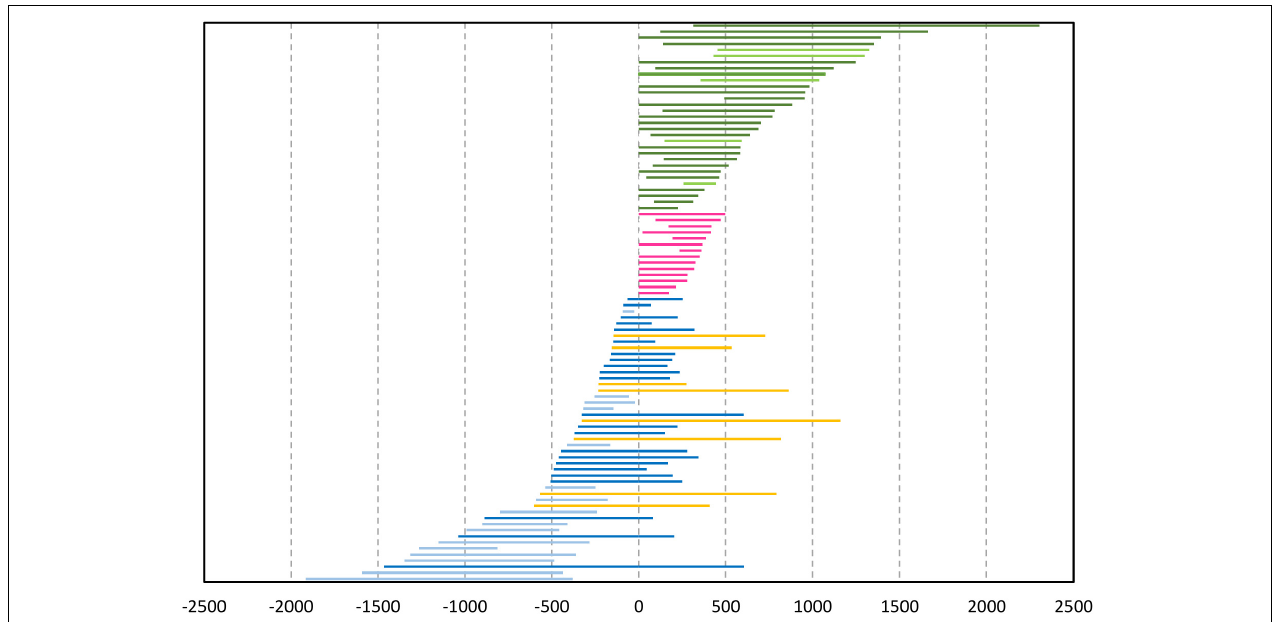
FIGURE 2 | Position and duration of stroke phases ( N = 92) in relation to their verbal affiliates in the data (measured in milliseconds; 0 marks the onset of the affiliate). Yellow lines mark gestures with cross-extending strokes, while pink lines mark verb-synchronized gestures. Lighter tones in the color categories denote gestures that end before (blue) or begin after (green) the verbalization of the